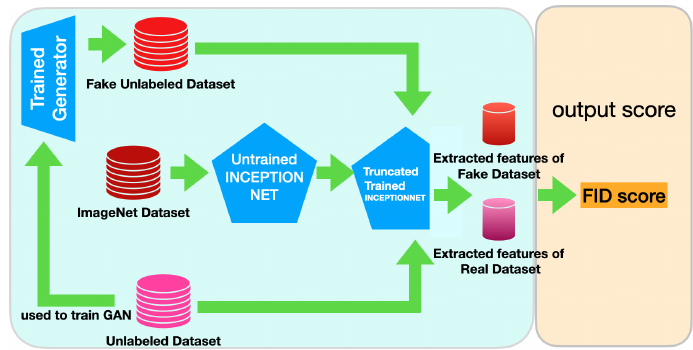
Figure 4. The architecture of an oracle instance based on FID Score.